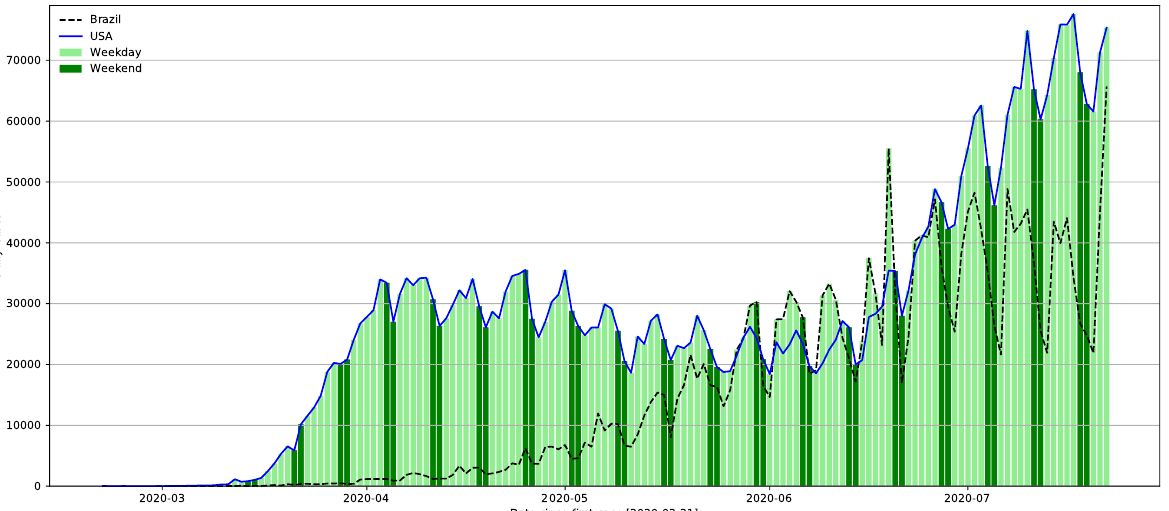
Figure 8. Number of daily cases in Brazil and